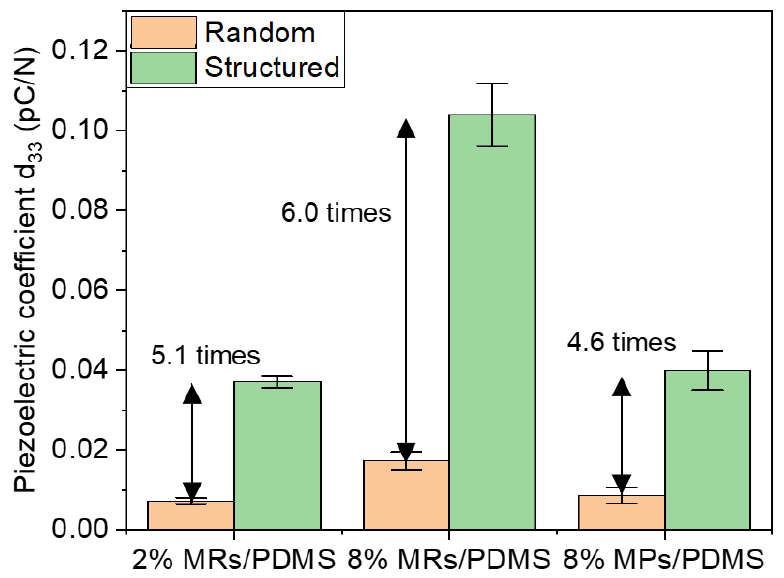
Figure 13. Piezoelectric coefficient ( d 33 ) measured at 1 Hz for different random and structured (i.e., aligned) ZnO MR/PDMS and MP/PDMS composites.